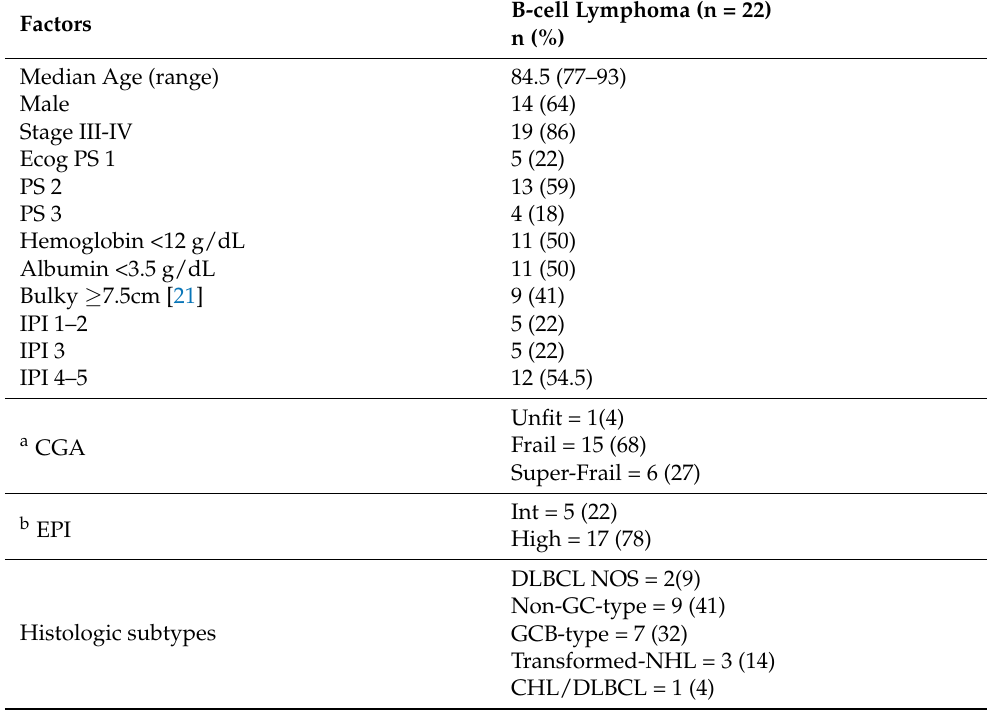
Table 2. Clinical features and Response in 22 Elderly/Frail patients with DLBCL, treated upfront with